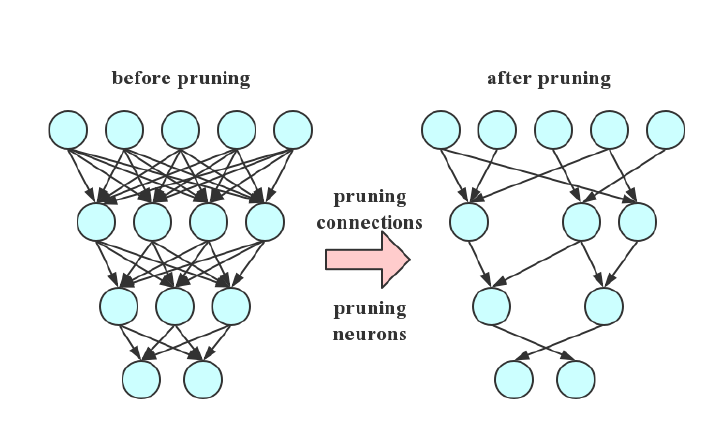
Figure 2. Connections and neurons before and after pruning.